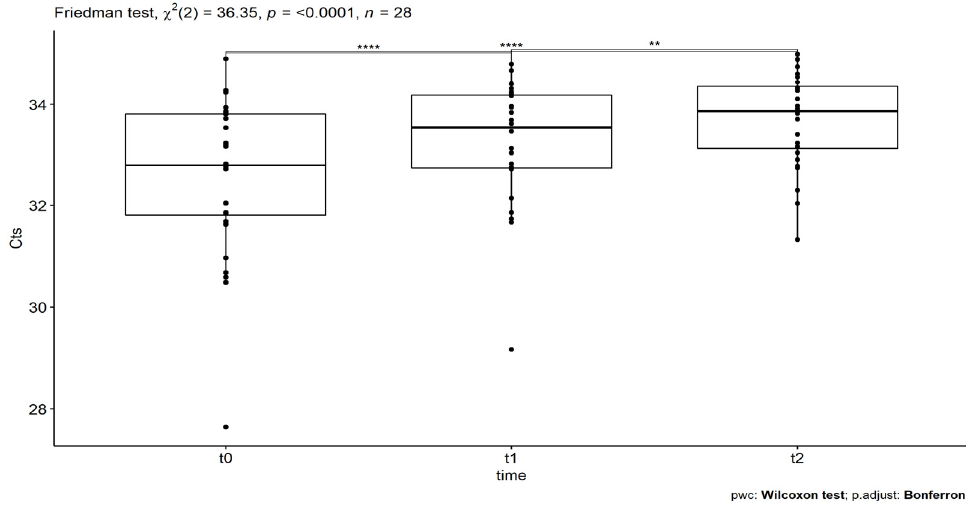
Figure 2. The boxplots of Ct measurements for Lyme disease at the different time points are t0 (be ‐ fore the first SOT administration), t1 (after the first treatment administration), and t2 (after the sec ‐ ond treatment administration). The asterisks denote significance codes, namely ‘****’ stands for p ‐ value < 0.0001 and ‘**’ stands for p ‐ value < 0.01, after Bonferroni correction. The increases in the values of Ct were found to be statistically significant. values of Ct were found to be statistically